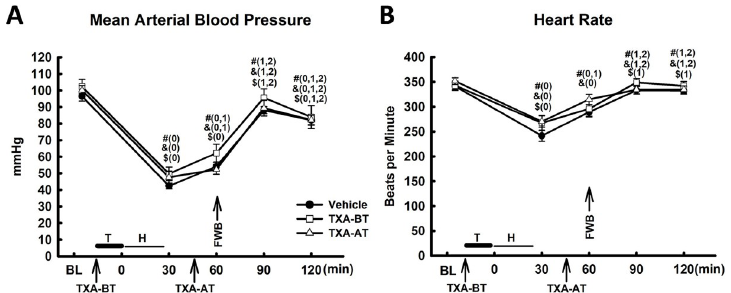
Fig 2. Hemodynamic change (n = 10 per group). (A) Mean arterial blood pressure (MAP); (B) Heart rate. T: Trauma; H: Hemorrhage; FWB: Fresh Whole Blood; #: Vehicle; &: TXA-BT; $: TXA-AT; “0”, “1”, “2” and “3” were presented as a significant difference in comparison to “Baseline”, “30min”, “60min”, and “90min” respectively within the group of Vehicle, TXA-BT or TXA-AT. There was no significant difference in MAP and heart rate among the groups at any given time